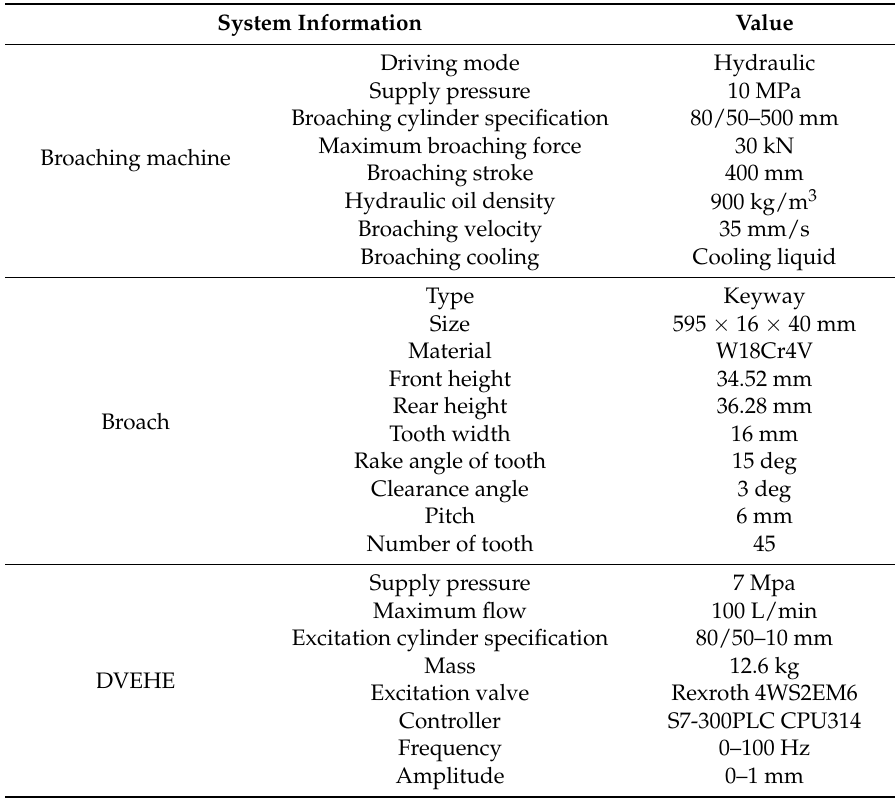
Table 1. Parameters of experimental